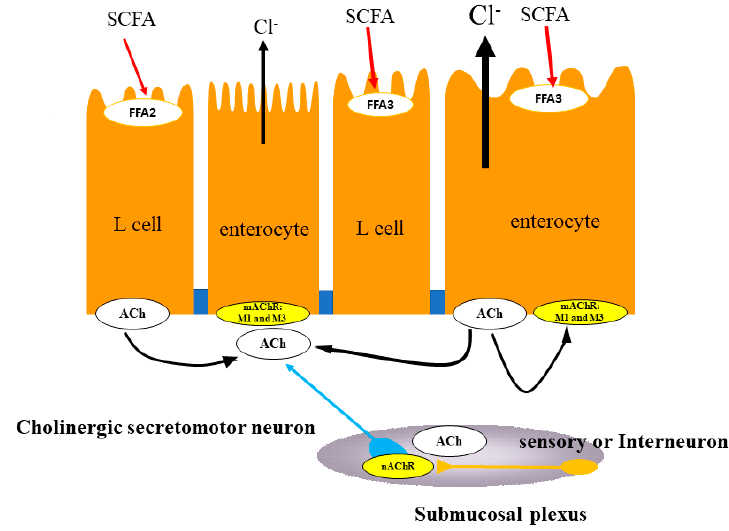
Figure 3. Proposed mechanism of SCFA sensing in the proximal colon. Propionate stimulates chloride secretion via sensory and cholinergic systems of the mucosa in rat distal colon. Luminal addition of propionate and serosal addition of ACh induce Cl − secretion Atropine significantly inhibits propionate-induced Cl − secretion and abolishes ACh-induced response. TTX has no effects on ACh-induced Cl − secretion. Luminal propionate induces ACh release into the serosal fluid. Luminal addition of 3-chloropropionate, an inactive analogue of propionate, abolishes both ACh release and increases in Isc response induced by propionate. The non-neural ACh release from distal colonic epithelia coupled with propionate-induced Cl − secretion plays a key role in Cl − secretion, via paracrine fashion of ACh on muscarinic receptors of colonocytes in addition to cholinergic secretomotor neurons.